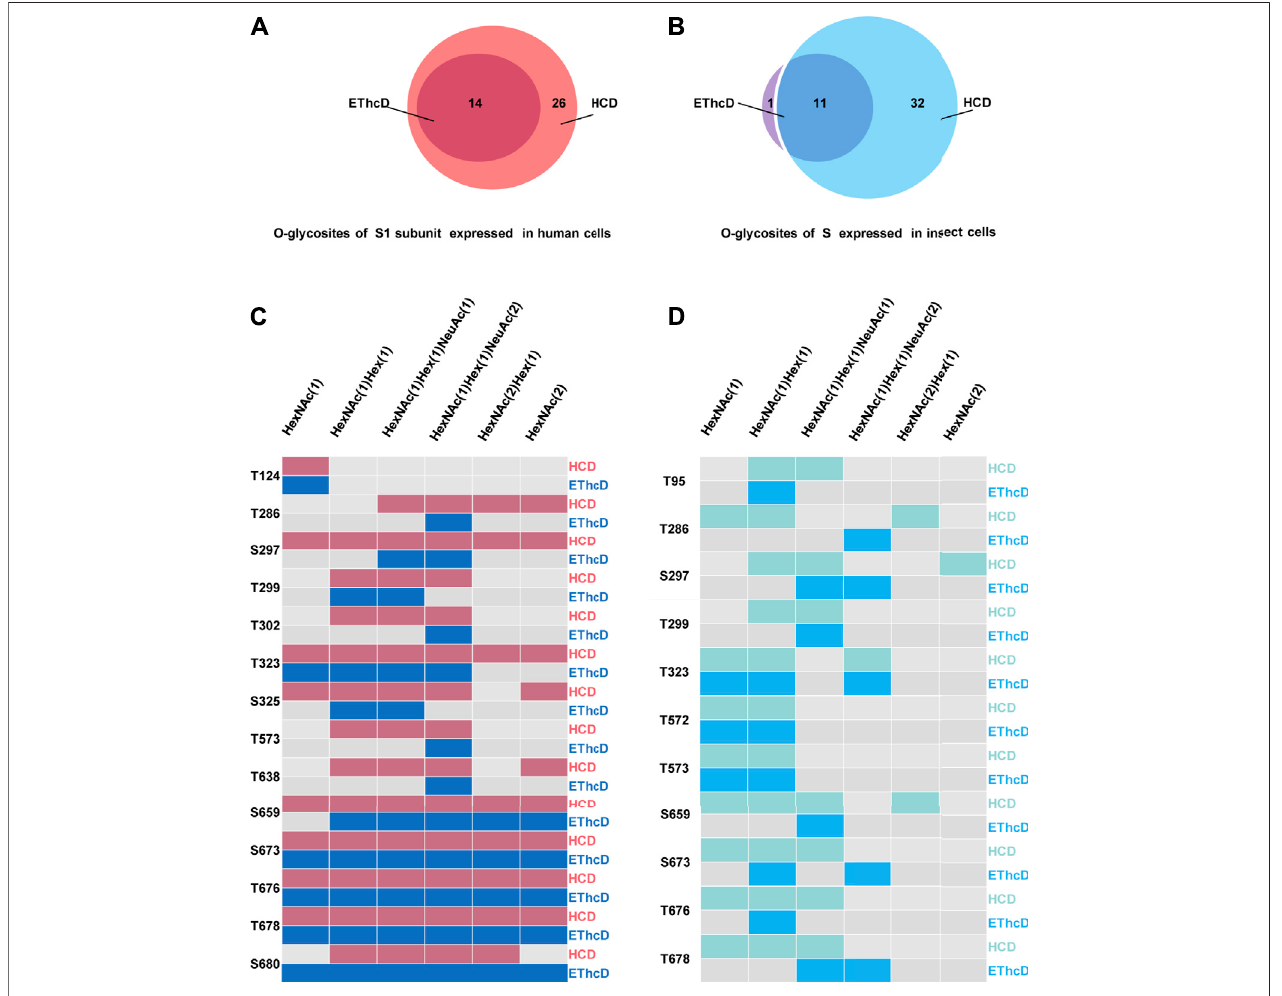
FIGURE 5 | Systems analysis of O-glycosylation of spike protein via EThcD and HCD mass spectrometry. (A) Identi fi ed O -glycosites of S1 subunit expressed in humancellsusingHCDand EThcD. (B) Identi fi ed O -glycositesofSexpressedininsectcellsusingHCDand EThcD. (C) Thesame O -glycositesofS1subunitexpressed in human cells identi fi ed using both HCD and EThcD. (D) The same O -glycosites of S expressed in insect cells identi fi ed using both HCD and EThcD.